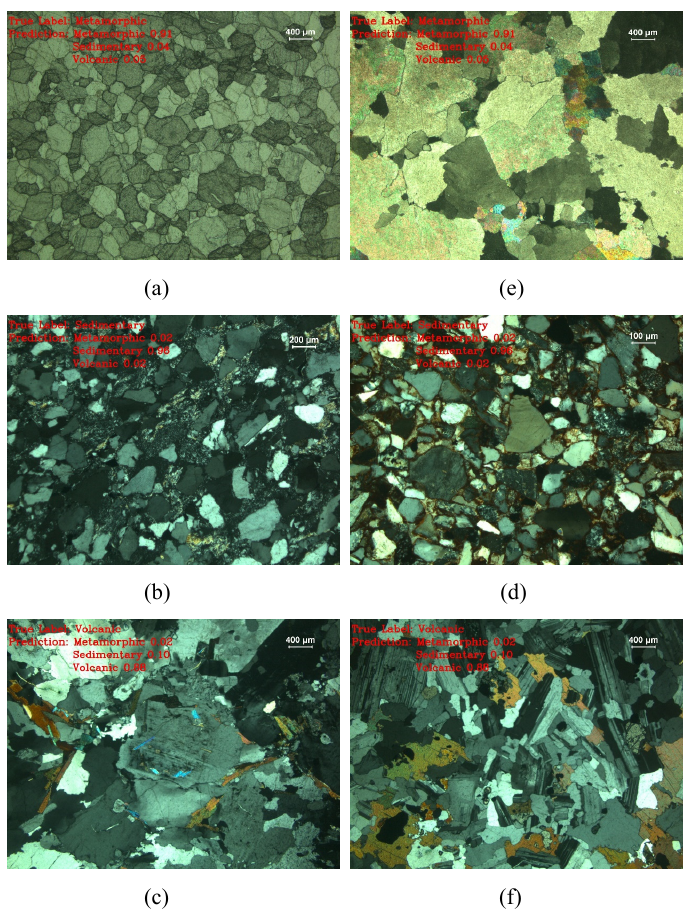
Figure 27. Classification results of other data: ( a , e ) metamorphic rock classification results; ( b , d ) sedimentary rock classification results; ( c , f ) volcanic rock classification results.